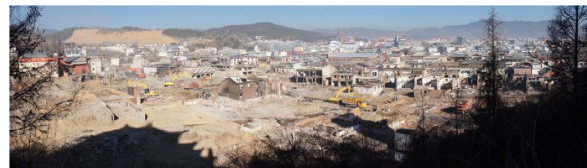
Figure 1. Dorkhar Historic Town after the Fire Photo: Dr. Ing. HUO Xiaowei